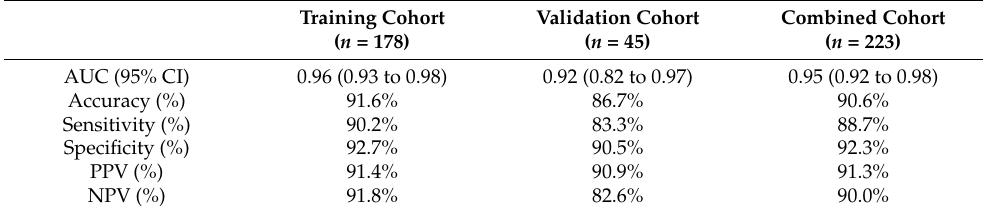
Figure 4. Receiver operating characteristic curves (ROC), calibration curves and decision curve analysis of the ABVS radiomic nomogram in training and validation cohort. ( A ) In the training and validation cohort, the AUC of the radiomic nomogram (red lines) were 0.959 and 0.925, and the AUC of the radiomic score (blue line) were 0.875 and 0.897, respectively. ( B ) The calibration curves of the nomogram were close to the standard curves in the training and validation cohort, which suggested that the nomogram was well-calibrated. ( C ) Decision curve showed that when the threshold probability was more than 5% in the training cohort and 2% in the validation cohort, using the nomogram had more benefit than either assuming all BI-RADS 4 lesions were malignant or assuming all lesions were benign. Table 3. Performance of the radiomic nomogram in training cohort, validation cohort and com- bined